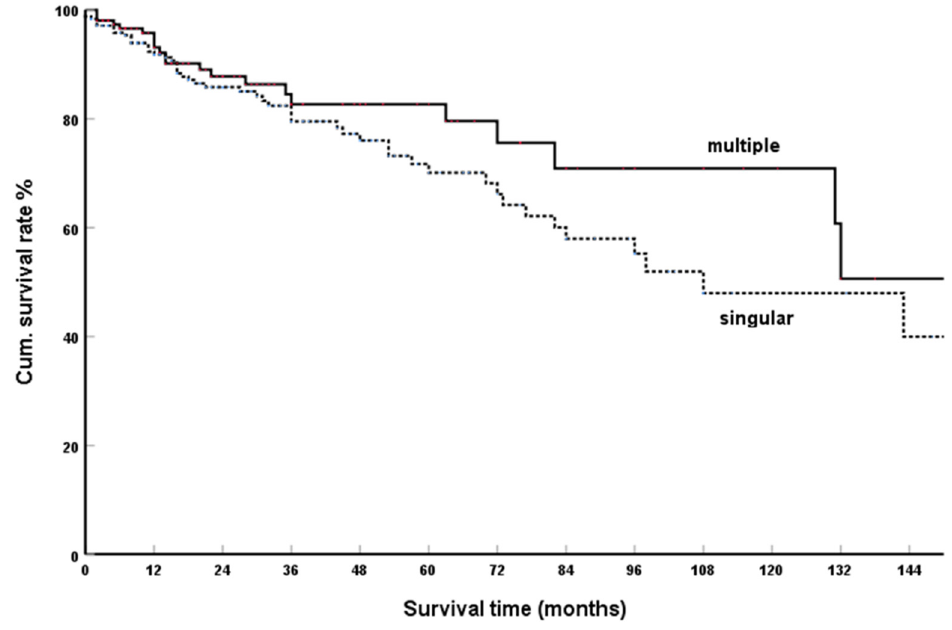
Figure 3. Solitary vs. multiple isPMRCC; Kaplan-Meier survival curves ( p = 0.162).